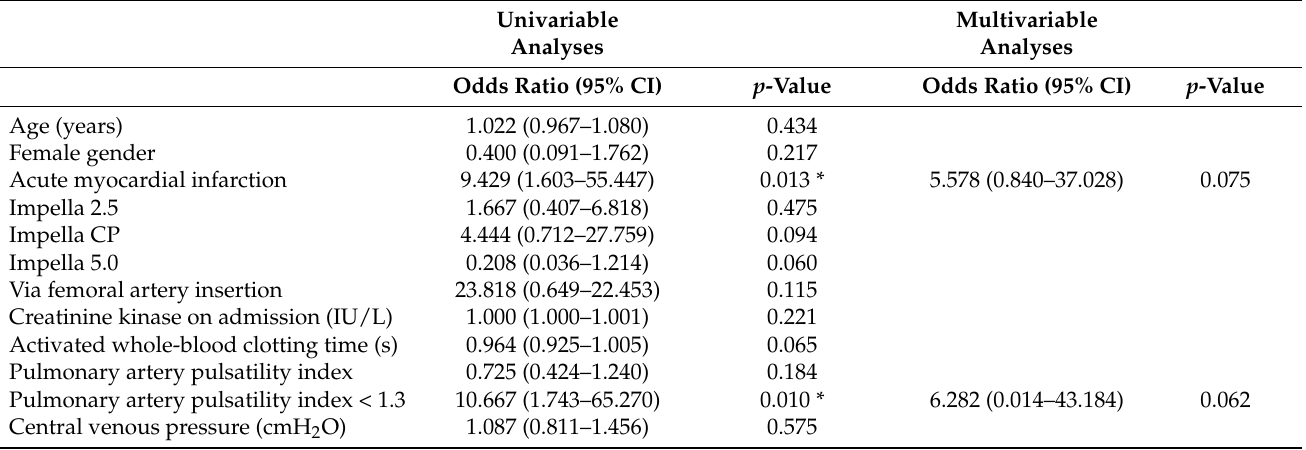
Table 5. Univariable and multivariable analyses for the hemolytic event among only Impella use